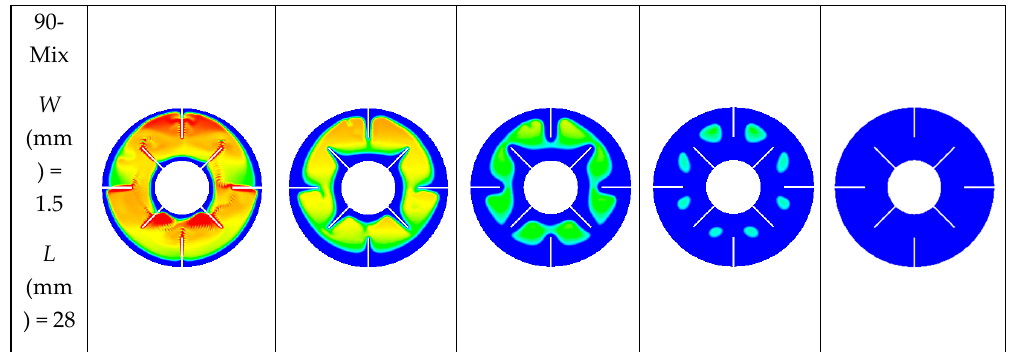
Figure 7. The effect of fins dimensions on the liquid fraction distribution.